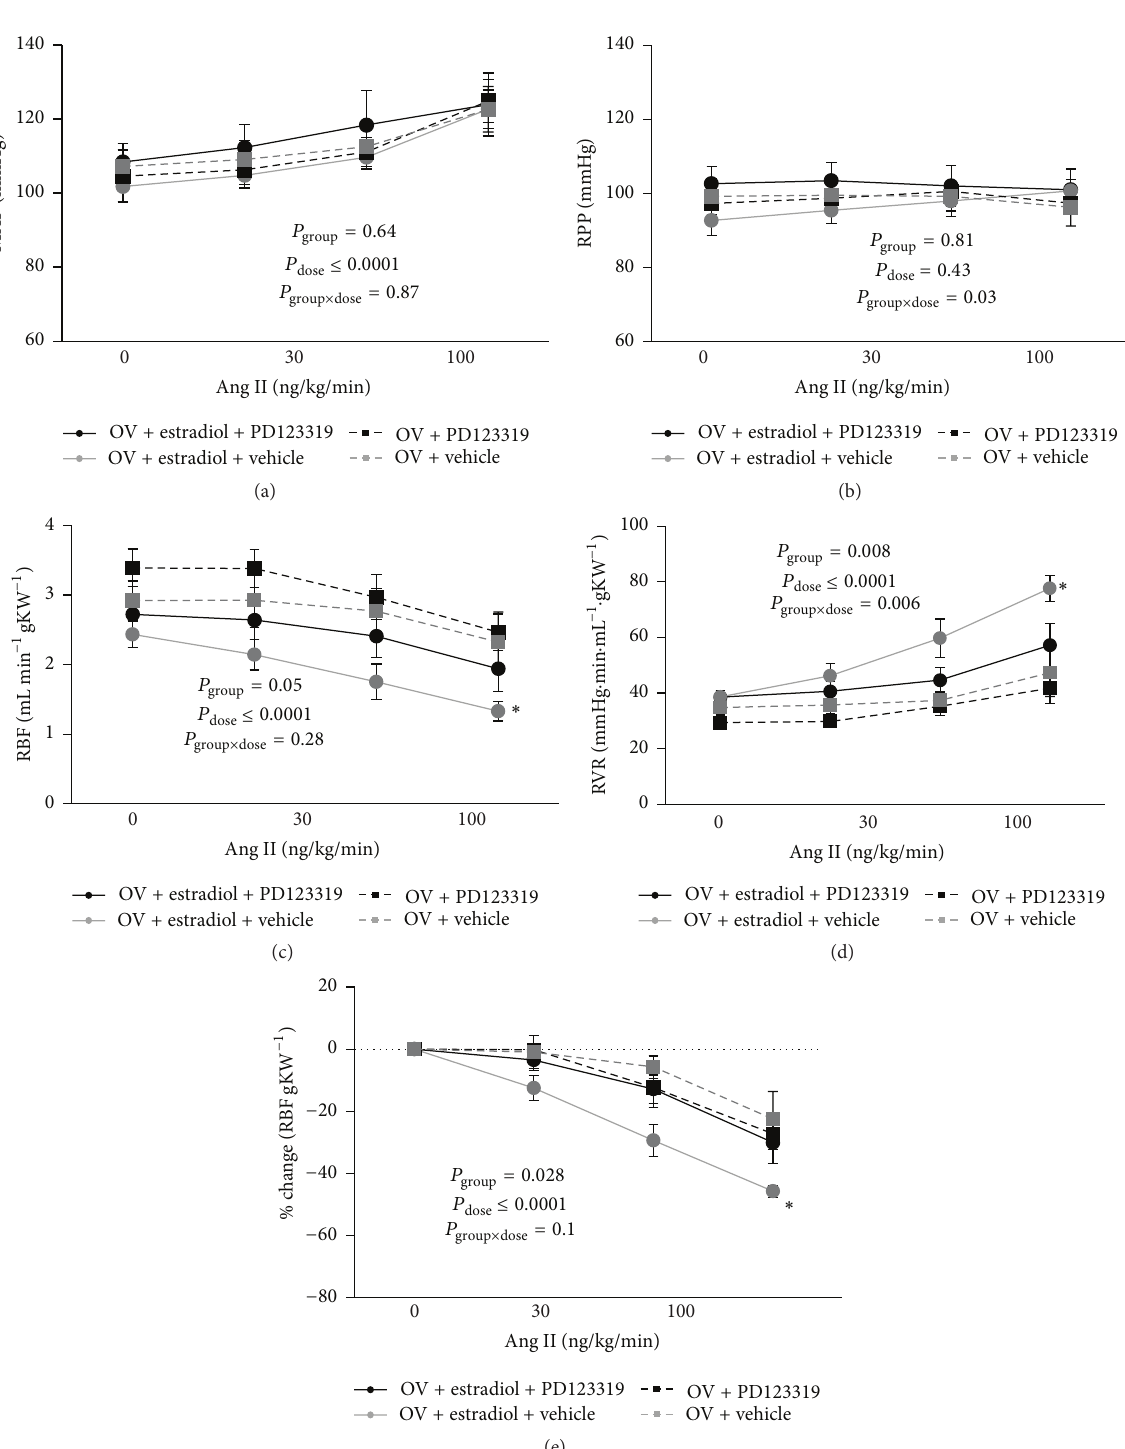
Figure 2: Effects of vehicle or PD123319, on responses to Ang II infusion. Data are shown as mean ± SEM. The data for RBF are also presented as percentage change from baseline. 𝑃 values were derived from repeated measures ANOVA with factors group, dose (of Ang II), and their interaction. ∗ represents 𝑃 ≤ 0.05 for comparison of the response to 300 ng/kg/min in ovariectomized rats treated with estradiol and the vehicle for PD123319 compared with all other groups, derived from Tukey’s post hoc test. 𝑛 = 5 per group. MAP, mean arterial pressure; RPP, renal perfusion pressure; RBF, renal blood flow per gram kidney weight; RVR, renal vascular resistance; OV, ovariectomized